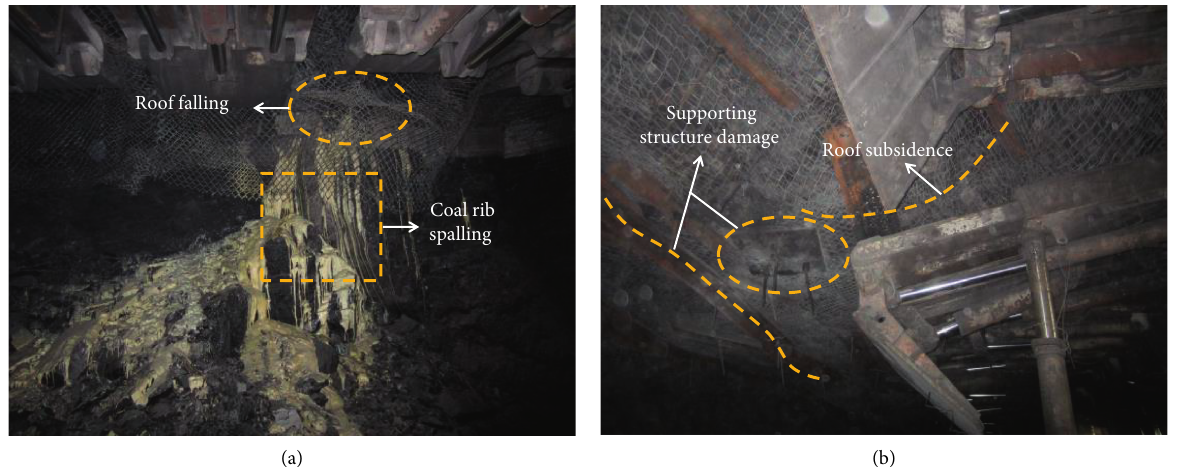
Figure 4: Deformation and damage of N0481 retracement channel. (a) Coal rib spalling and roof falling. (b) Roof subsidence and supporting structure damage.